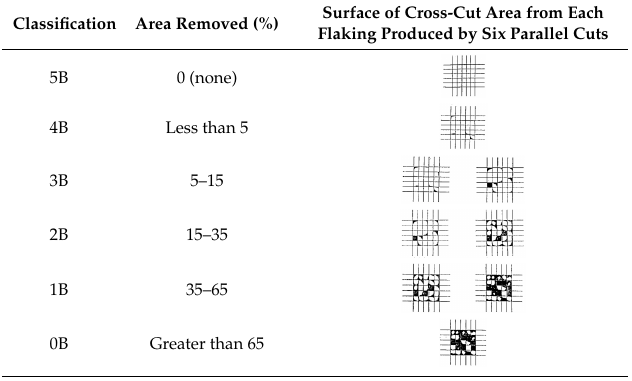
Table 1. Classification of cross-hatch adhesion values according to ASTM D3359-09 standard. Classification Area Removed (%)